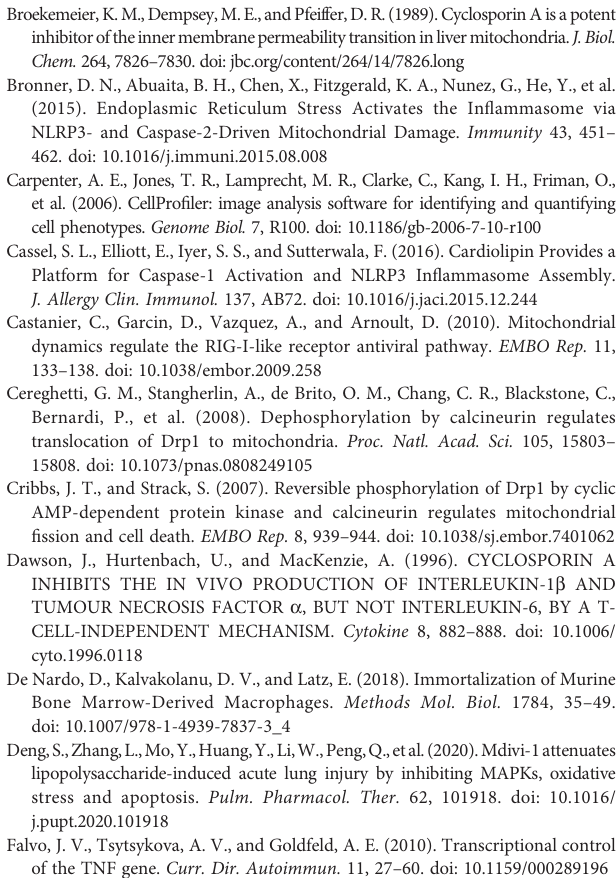
SUPPLEMENTARY FIGURE 1 | Immunoblot analysis of mitochondrial fi ssion and fusion machinery in macrophages during LPS stimulation. (A) Immunoblot comparing DRP1 protein content in primary differentiation BMDM vs. DRP1 KD and NT-Control immortalized BMDM +/- 4 h LPS stimulation (200 ng/ml). Lysates from equivalent numbers of cells (7.5×10 4 ) were loaded to control for cell type-intrinsic differences in protein content. (B) DRP1 abundance was quanti fi ed relative to mitochondrial content (TOM20) based on immunoblots. (C) Analysis of mitochondrial fi ssion and fusion regulators in 4 h LPS-stimulated macrophages by immunoblot. The abundance of DRP1 activating phosphorylation at Ser635, DRP1 inhibitory phosphorylation at Ser656, Mitochondrial fi ssion factor (MFF), key mitochondrial fusionproteins,Mitofusion2(MFN2)andOpticatrophy 1(OPA1),and mitochondrial OM marker TOM20 and matrix marker Pyruvate Dehydrogenase (PDH) were assessed. (D) Quanti fi cation of DRP1 Ser635 and Ser656 phosphorylation relativetototalDRP1(tDRP1)andTOM20, MFN2,OPA1,andMFF relative to GAPDH. * Graphs are presented as the mean of n ≥ 3 independent experiments ± SD. Two-way ANOVA with Sidak ’ s multiple comparisons post-test was used to determine statistical signi fi cance. P < 0.05; ** P < 0.01; *** P < 0.001. SUPPLEMENTARY FIGURE 2 | Quanti fi cation of mitochondrial morphology using CellPro fi ler. (A) CellPro fi ler work fl ow for mitochondrial fragmentation and skeletonization analysis of Complex I immuno fl uorescence images. (B) Mitochondrial and total cell objects were segmented based on Complex I and Cell Tracker Red CMTPX stains, respectively. Representative processed images of NT- Control and DRP1 KD macrophages showing fragmented mitochondria in red and non-fragmented mitochondrial objects in teal overlaid on Complex I images. Similarly, skeletonized mitochondrial networks (red) are shown overlaid on Complex I images. Cells wereleft untreated (Mock) orstimulated with LPS(200 ug/ml) for 4 h. (C) Quanti fi cation of mitochondrial fragmentation and length at the cell level. Fragmented mitochondria were classi fi ed based on mitochondrial object size and